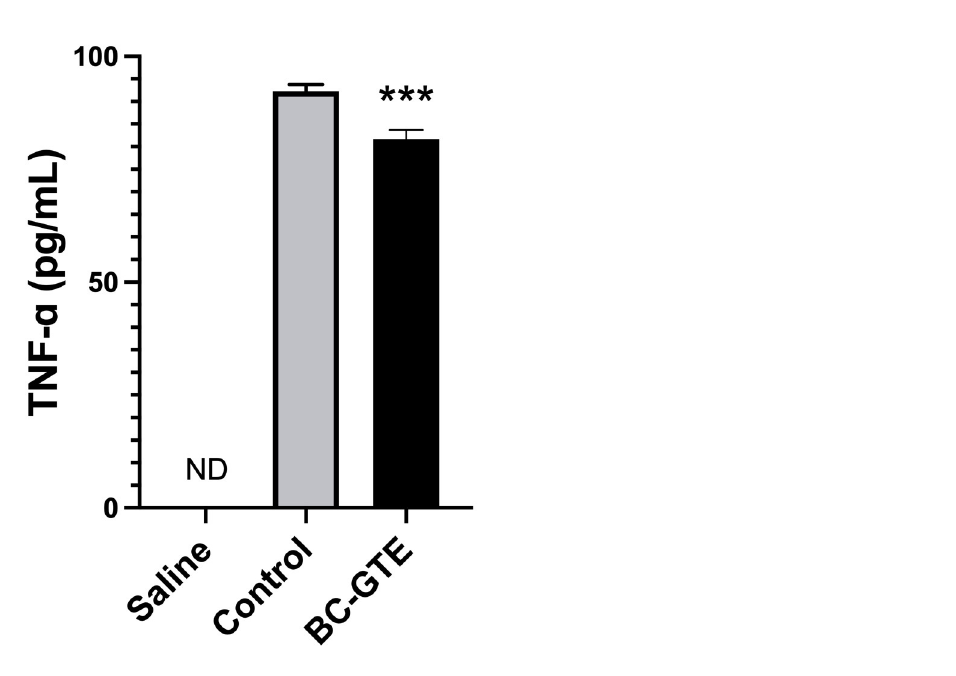
Figure 4. Experimental data presenting the serum TNF- α levels of BC-GTE on LPS-induced adult rats. Abbreviations: BC-GTE—extract treated animal group; ND—not detected. (***) p < 0.001 control vs. BC-GTE group. The values are mean ± SEM, n = 6.